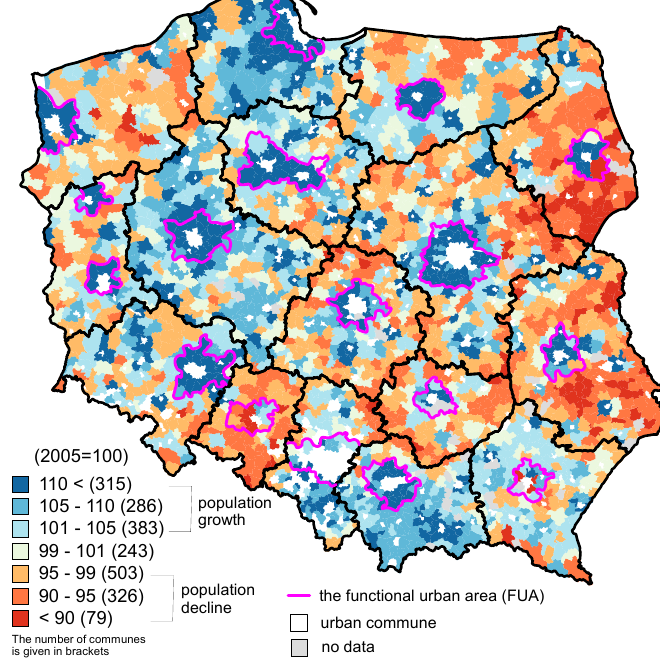
Figure 3. Rural population change in 2005–2018. Source: own work based on the Local Data Bank of Statistics Poland (BDL GUS) data and [34] (p. 196–197).